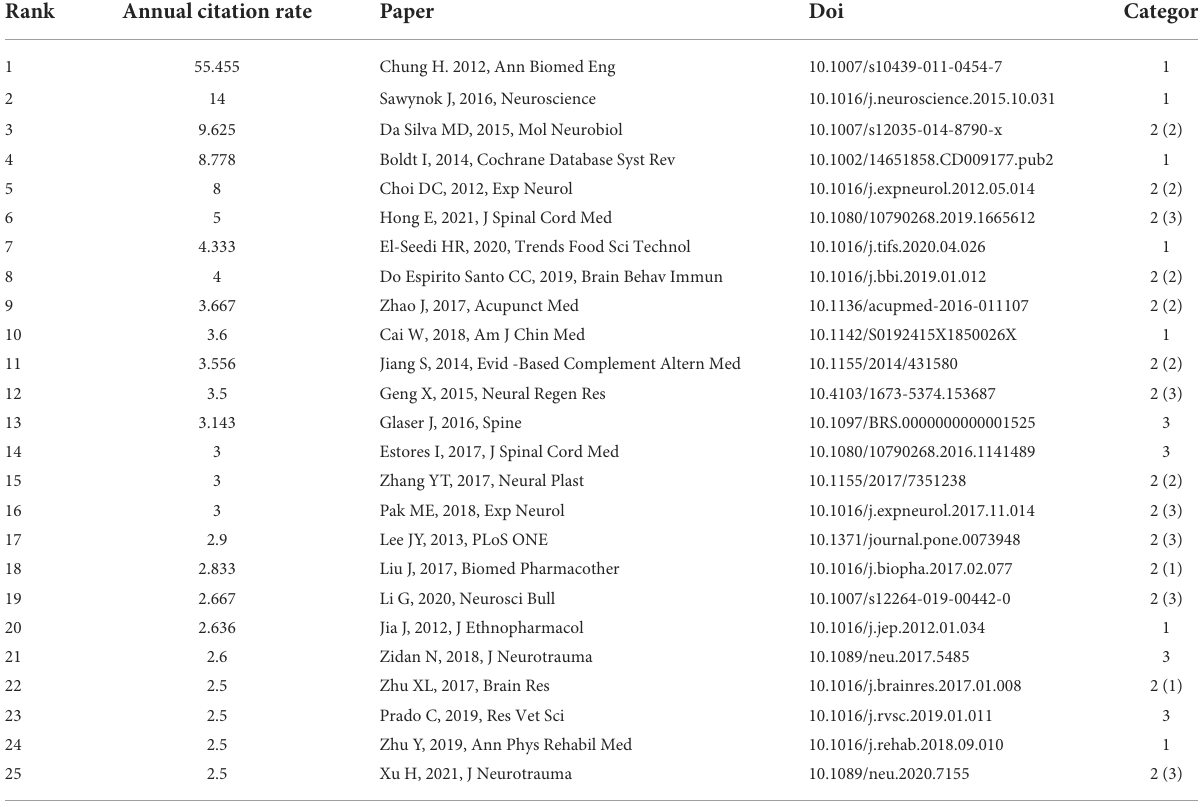
TABLE 5 Publications with annual citation rates more than or equal to 2.5 and their categories. Rank Annual citation rate Paper